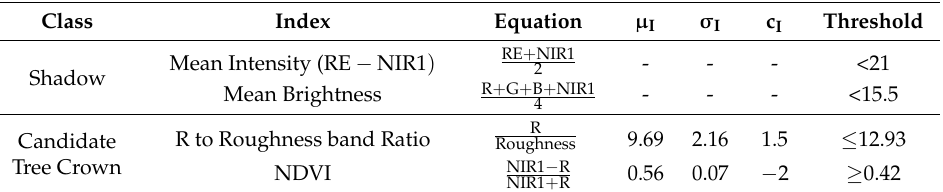
Table 1. Indices and class description for shadow and CTC objects